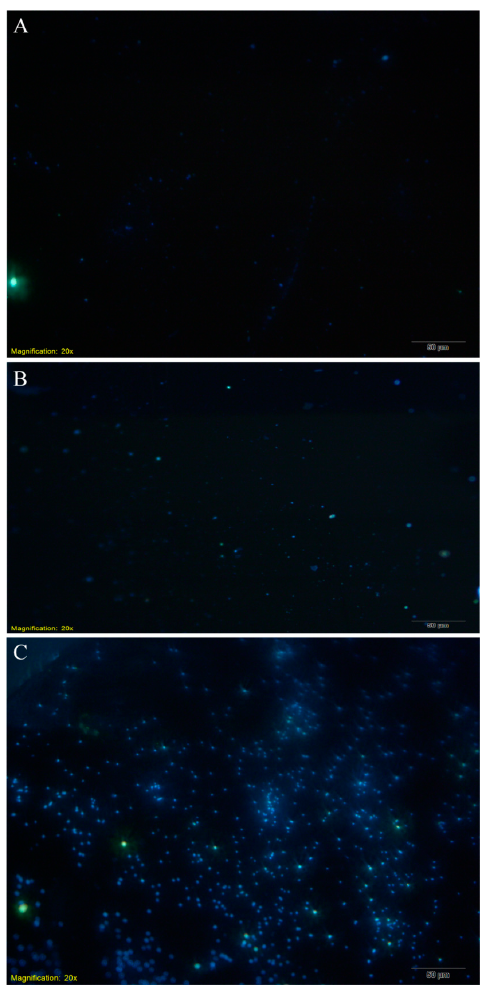
Figure 5. Fluorescence microscopy of the electrode surface after electrochemical detection. ( A ) The electrode surface after detection of sterile electrolyte; ( B ) the electrode surface after detecting elec- trolyte with bacterial concentration of 10 5 CFU/mL; ( C ) the electrode surface after detecting electro- lyte with bacterial concentration of 10 8 CFU/mL. The yellow fluorescence represents impurity par- ticles, and the blue fluorescence represents E. coli cells. The number of bacteria adsorbed on the GCE surface increases with the increase of the bacterial concentration in the electrolyte. In the present study, we also examined the electrochemical response of the Gram- positive strain S. aureus (Figures S6 and S7), which was found to be significantly different from that of E. coli . This could be attributed to the unique cell wall structure [47] and smaller cell size [48] of S. aureus . Ronspees and Thorgaard [30] reported that Bacillus